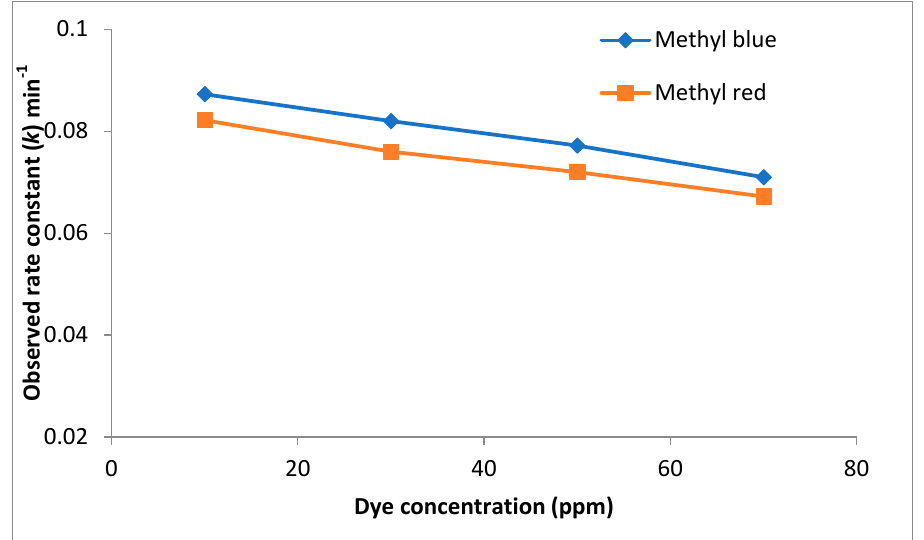
Figure 11. Variation of observed rate constants ( k ) of methylene blue and methyl red with increasing concentrations of dyes.